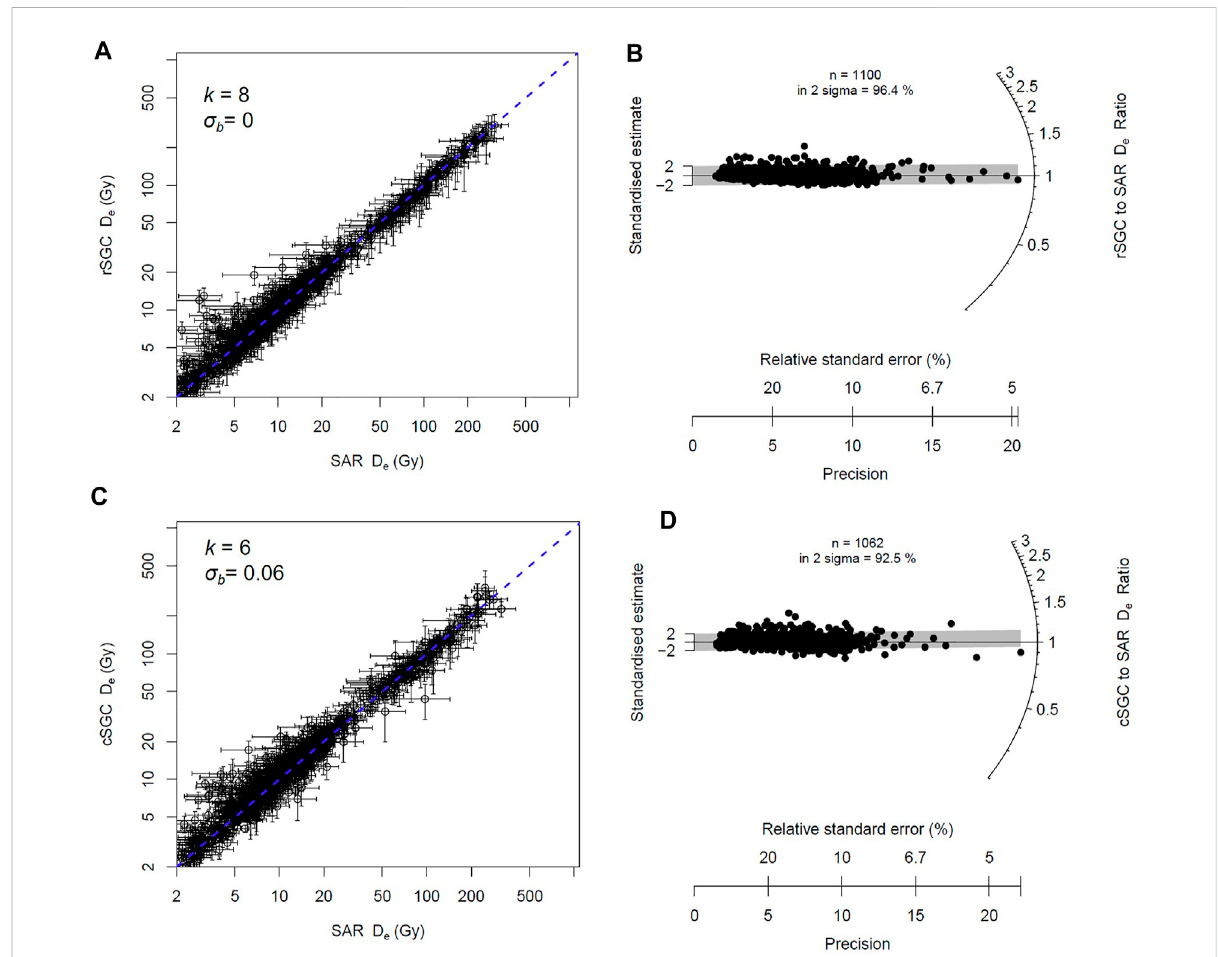
FIGURE 2 (A) Comparison of the SAR and rSGC D e values ( σ b = 0). The dashed line represents the 1:1 ratio. The ratios of the rSGC and SAR D e are radially plotted in (B) . (C) Comparison of the SAR and cSGC D e values, and the corresponding ratios are radially plotted in (D)